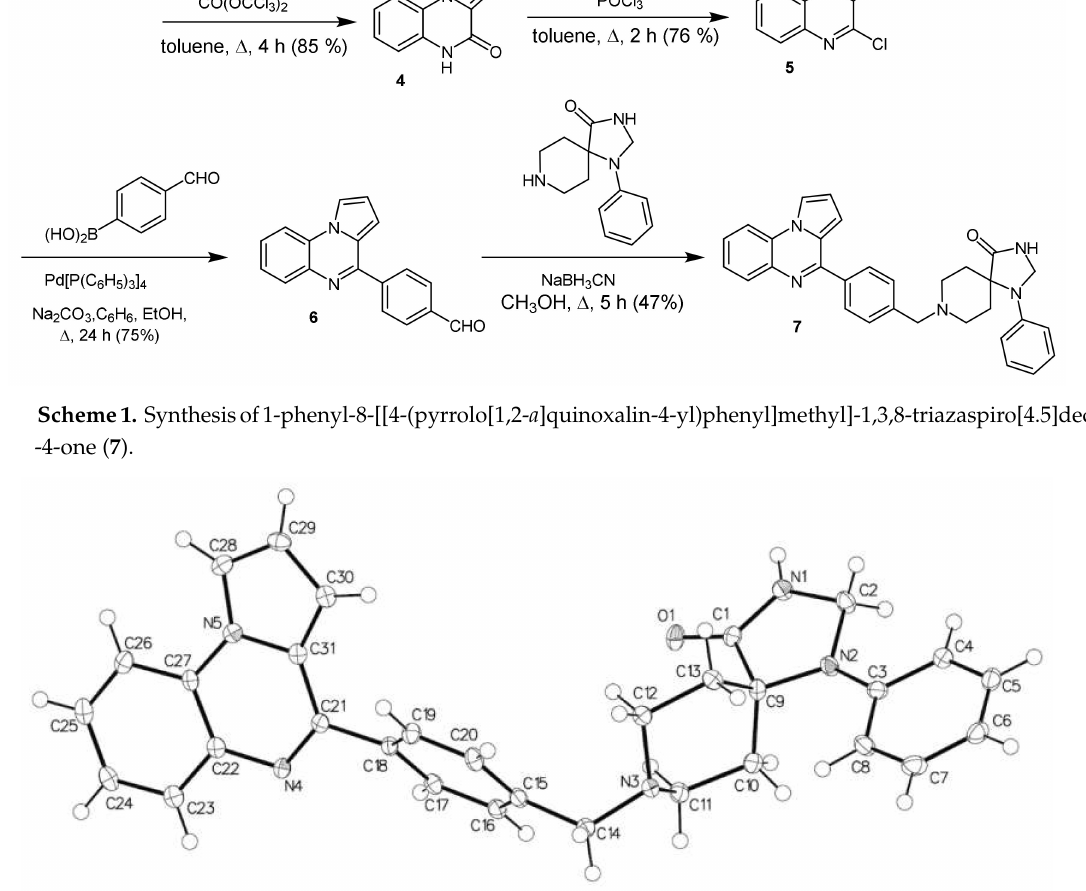
Figure 2. The ORTEP (Oak Ridge Thermal Ellipsoid Plot) drawing of the 1-phenyl-8-[[4-(pyrrolo[1,2- a ]quinoxalin-4-yl)phenyl]methyl]-1,3,8-triazaspiro[4.5]decan-4-one ( 7 ) with thermal ellipsoids at 30%